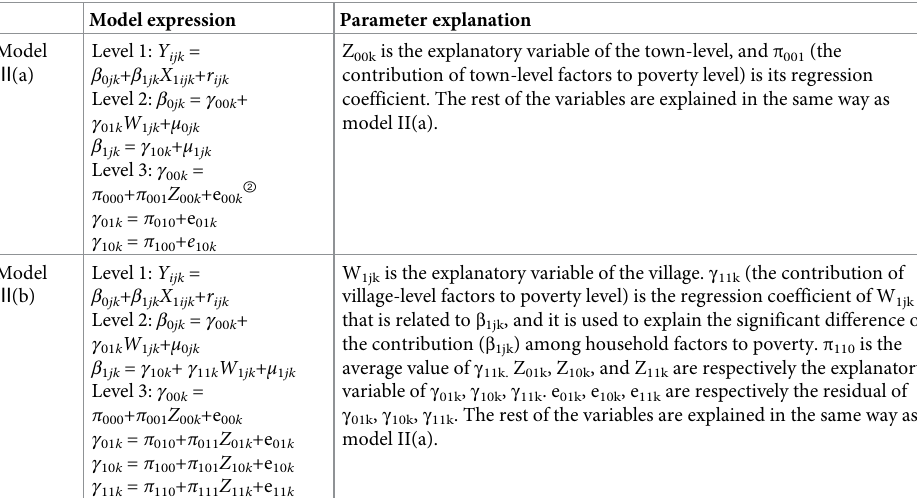
household-level influence factors in the first level. In order to more accurately explore the vil- lage-level significant poverty-stricken factors and avoid the impact of the town-level back- ground effect on poverty levels, this study do not add explanatory variables in the third level in Model II (b). The two three-level random effects regression models constructed are shown in Model III: Significant poverty-contributing factors and the interaction mechanism at household-village-town levels based on the full model. In this stage, we construct model III (a) based on model II (b). We add the town-level influencing factors in the intercept equation into the third level (as in Equation ② in Table 4), and add residuals to each equation of the model to explore the significant influence factors at the town-level, as well as the difference of the contribution of the household-level factors and the village-level factors to the poverty level. Further, based on model III (a), the village-level and the town-level explanatory variables are added to the regression coefficient equations of the household-level and village-level influenc- ing factors with significant differences in contribution to construct model III (b), which explains the possible reasons for the significant difference of contribution. The three-level complete model constructed is shown in Table 4: Table 4. The full